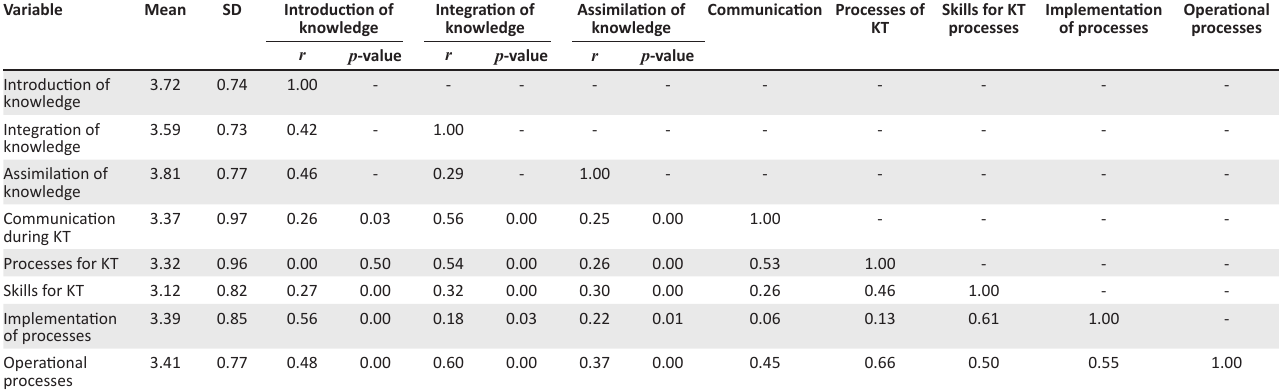
TABLE 4: Descriptive statistics for constructs and correlation. Variable Mean SD